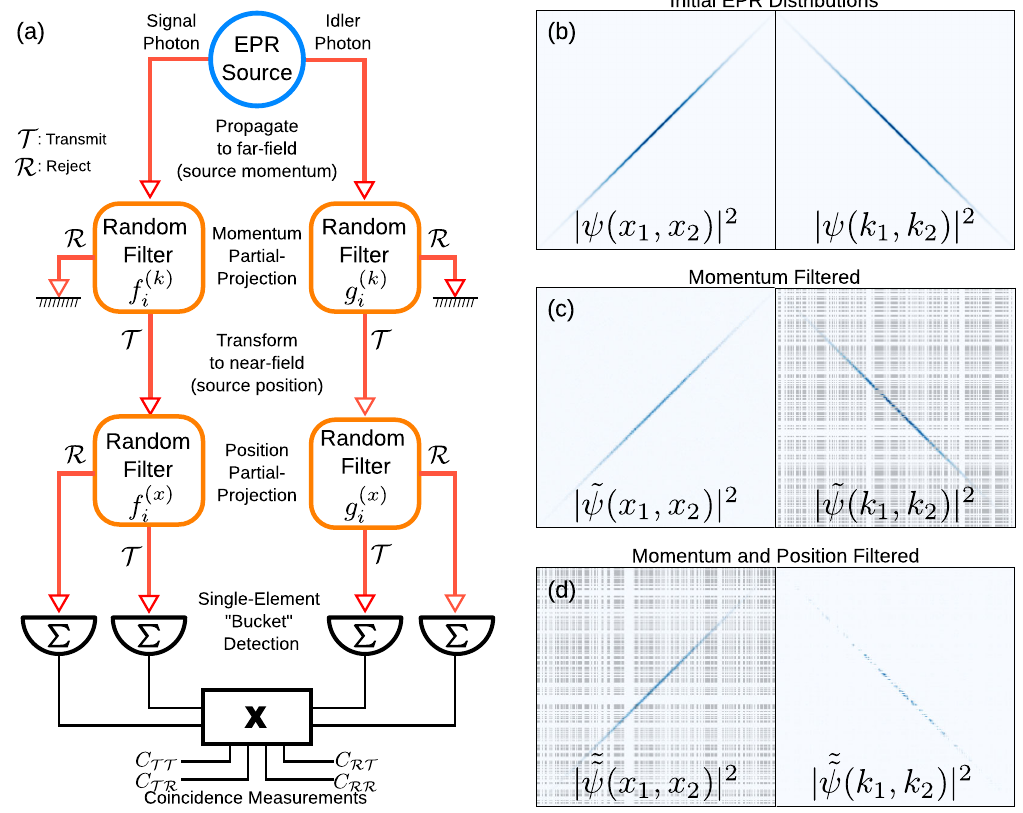
FIG. 1. Sequential, partial projections in position and momentum. The block diagram (a) describes a sequence of partially projective measurements on an EPR entangled source. (b – d) Simulated joint-position and joint-momentum distributions at each point in the experiment. Signal and idler photons from an EPR source (b) are separated and allowed to propagate to the far field (momentum). Here, they are subjected to random binary filtering by a pixelated mask (faded gray overlay). Each pixel in the mask either fully transmits ( T ) or fully rejects ( R ). The momentum-filtered fields (c) propagate through an optical system to an image plane of the source, where they are again filtered with random, binary filters (d). Single-element, photon-counting detectors are placed in the T and R ports of each filter and are connected to a coincidence circuit. The total number of coincident detection events between signal and idler channels gives a random projection of the momentum distribution. The relative distribution of coincident detections between the T and R modes (four possibilities) for the signal and idler photons gives a random projection of the position distribution up to a small noise floor injected by the momentum